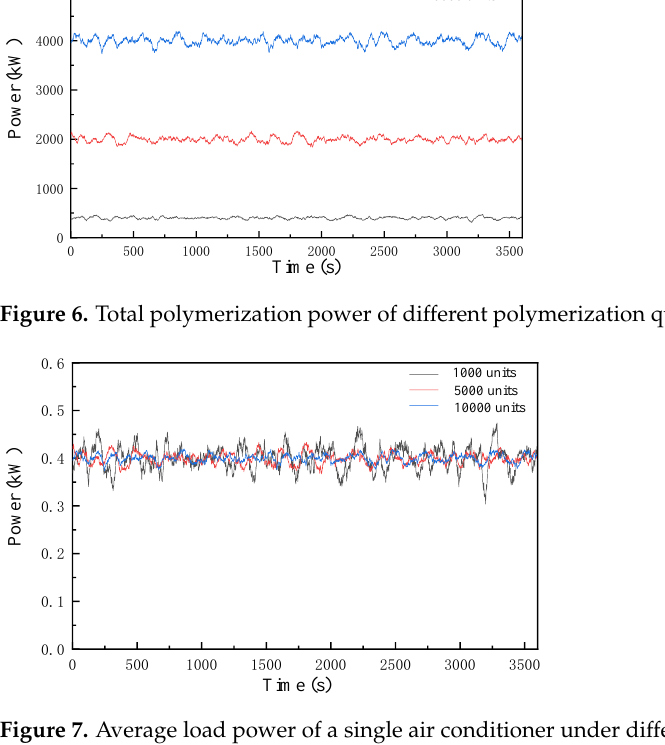
Figure 7. Average load power of a single air conditioner under different numbers of aggregates.